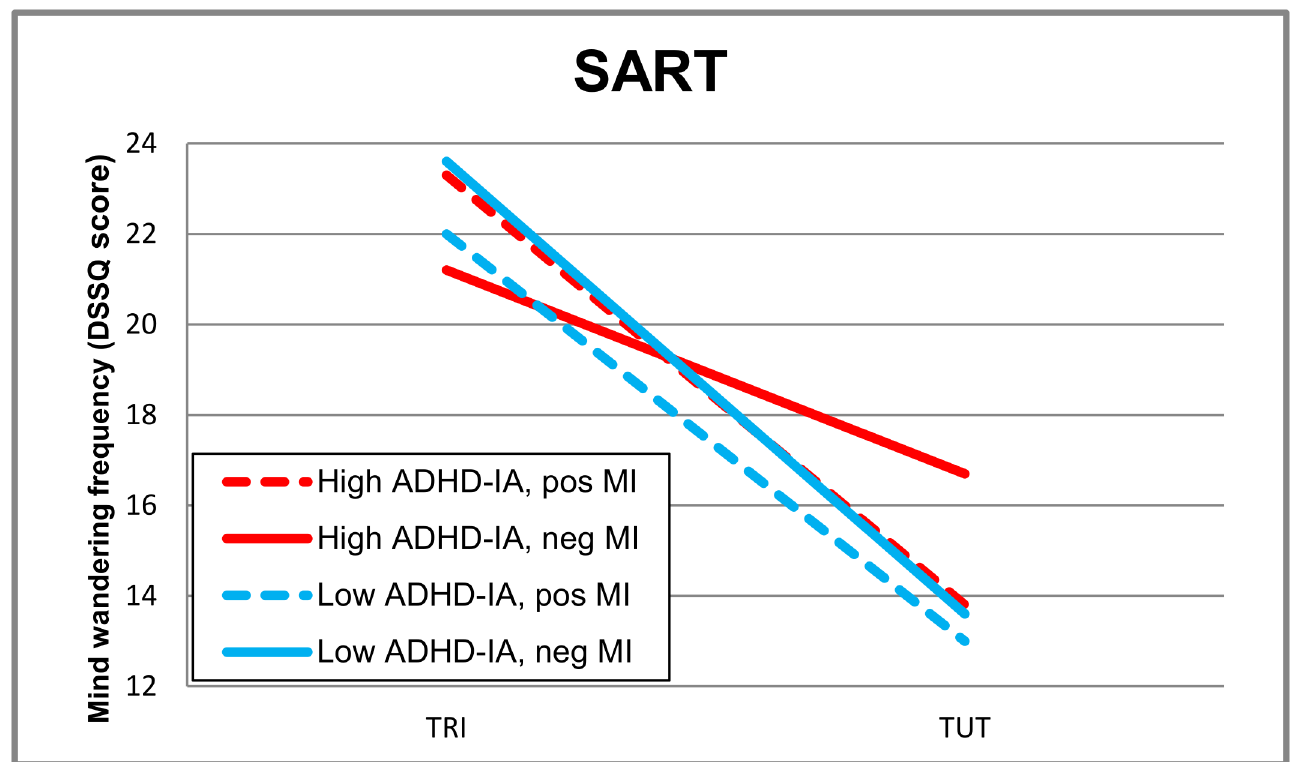
Fig 1. Mean Task-Related Interfering (TRI) and Task-Unrelated-Thought (TUT) scores on the post-task questionnaire (DSSQ) in the Sustained Attention to Response Task (SART) in high and low ADHD-Inattention (IA) symptom groups after positive (pos) or negative (neg) mood induction